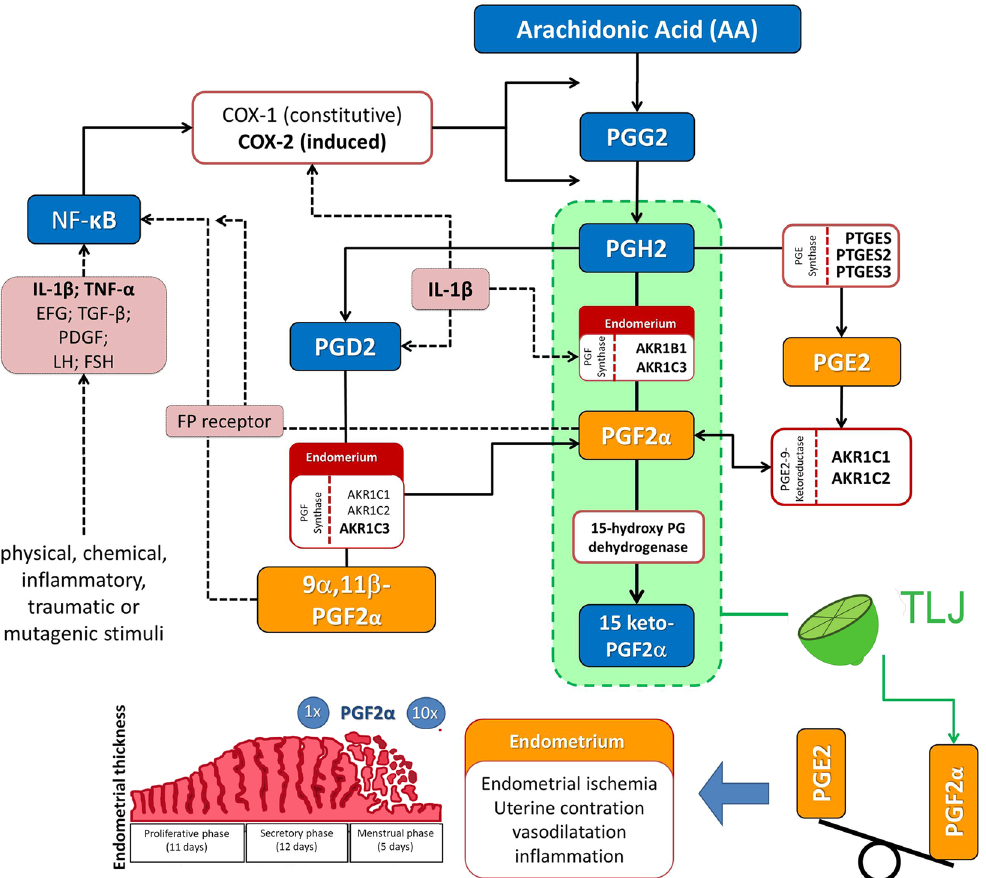
Figure 8. Pathways responsible for producing E2 and F2 α prostaglandins. PGF2 α and PGE2 are produced from arachidonic acid (AA) by cyclooxygenase enzymes (COX-1 and COX-2). In the first step, AA is metabolized in PGG2 intermediate by cyclooxygenase and, sequentially, in PGH2 by peroxidase. The PGH2 can be synthesized directly into PGF2 α by the AKR1B1 or AKR1C3 enzymes. Both AKRs are present in the endometrium during the menstrual cycle: AKR1B1 is in the glandular epithelium and stromal cells, and AKR1C3 is situated in the epithelial cells. PGH2 can also be converted into 9 α ,11 β -PGF2 α by the AKR1C3 and to a lesser extent by the AKR1C1 and AKR1C2 enzymes. The 9 α ,11 β -PGF2 α is a stereoisomer of PGF2 α and has the same potency in the contraction of smooth muscle fibers. Both the AKRs and F2 α prostaglandins (PGF2 α and 9 β , 11 β -PGF2 α ) act on the transcription of the NF −κβ factor, inducing the production of